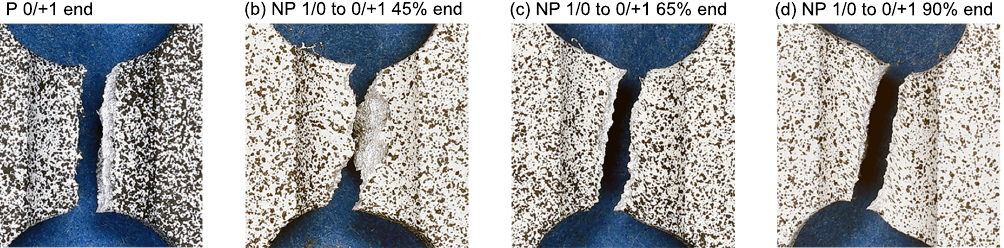
Figure 14. Fracture lines.